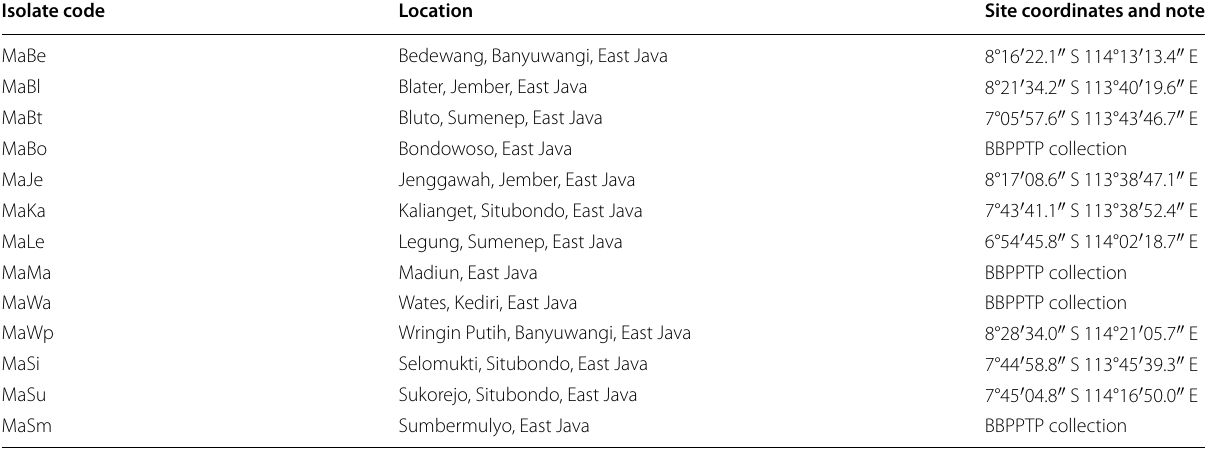
Table 1 Isolates of Metarhizium collected from infected Oryctes rhinocero s Isolate code